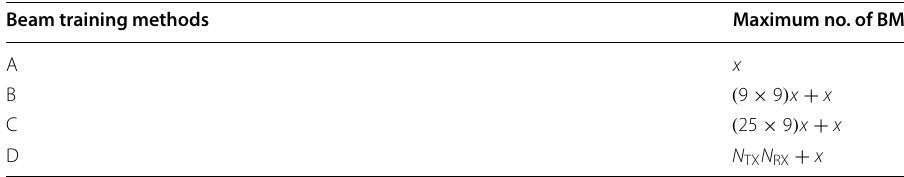
Table 3 Maximum number of beam measurements (BM) required for beam training methods (actions) A–D with x beams tracked over